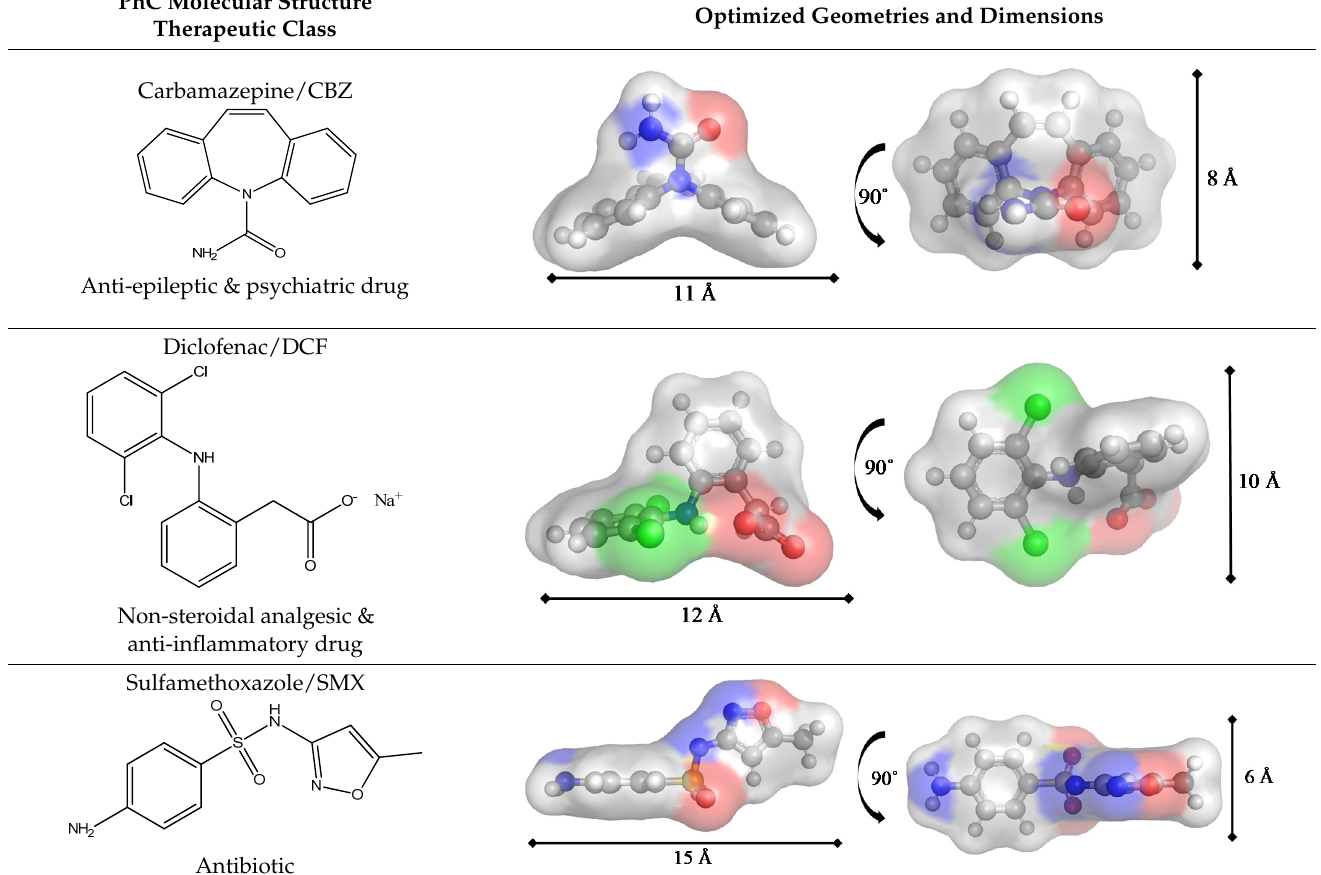
Table 2. Physical–chemical properties of the target PhCs. Characteristics.